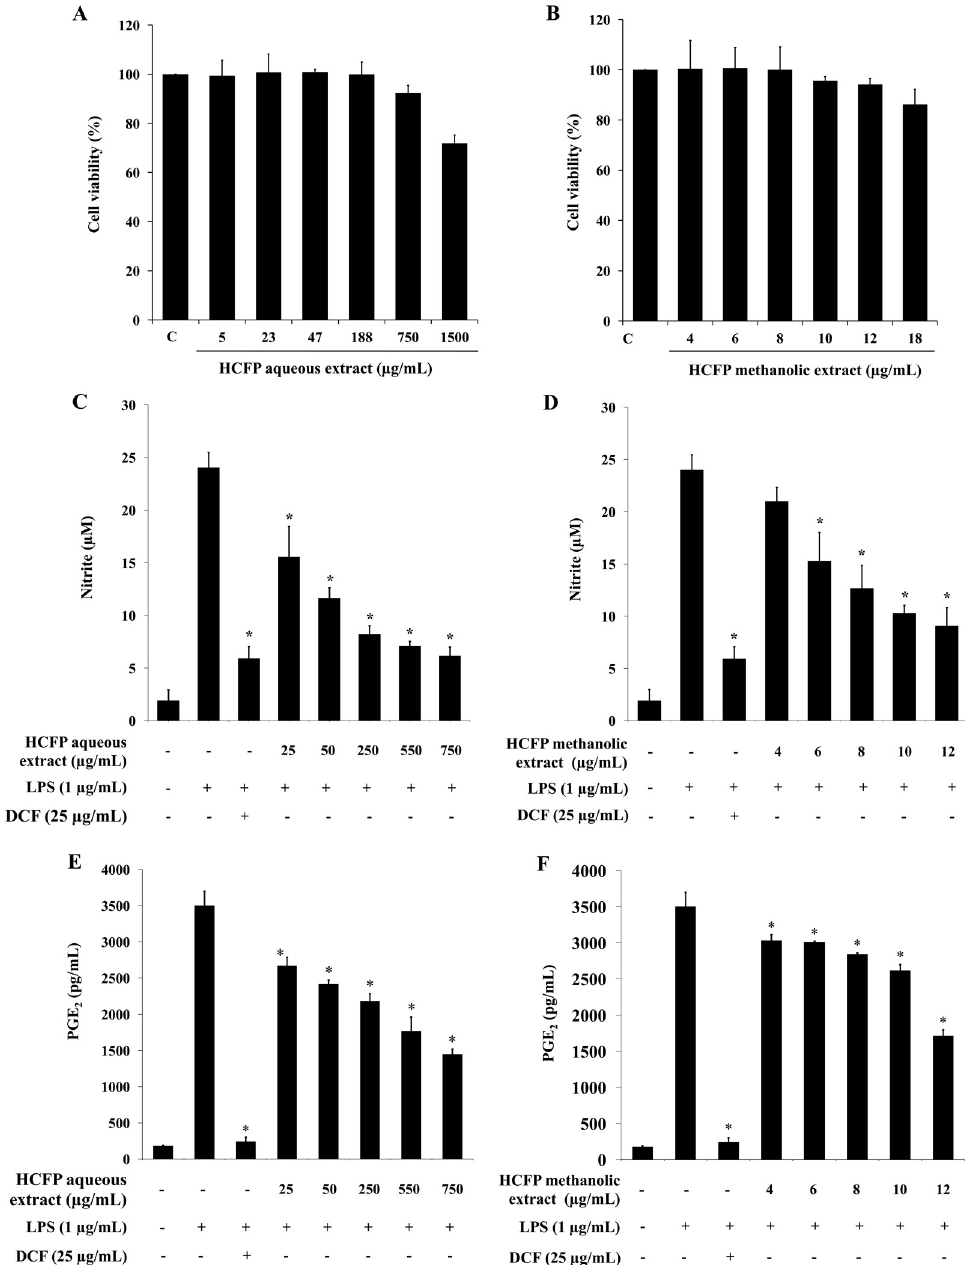
Fig 1. Effect of aqueous and methanolic extracts of HCFP on RAW264.7 cell viability (A, B), NO production (C, D) and PGE 2 levels (E, F) in LPS-stimulated RAW264.7 cells. RAW264.7 cells were incubated with aqueous (5–1,500 μ g/mL) and methanolic (4–18 μ g/mL) extracts for 24 h. Cell viability was assessed by MTT assay. The results were reported as a percentage of cell viability compared with untreated controls and expressed as mean ± S.D. of three independent experiments. For determinations of NO production and PGE 2 levels in LPS-stimulated RAW264.7 cells, the cells were pre-treated with indicated concentrations of aqueous (C, E) and methanolic (D, F) extracts for 2 h and then stimulated with LPS (1 μ g/mL) for 24 h. The nitrite production and PGE 2 levels in cultured medium were determined by using Griess reagent and PGE 2 EIA kit, respectively. Statistically significant inhibition of NO production and reduction of PGE 2 levels ( � p < 0.05) were found as compared with the LPS group. Data were obtained from three and two independent experiments,